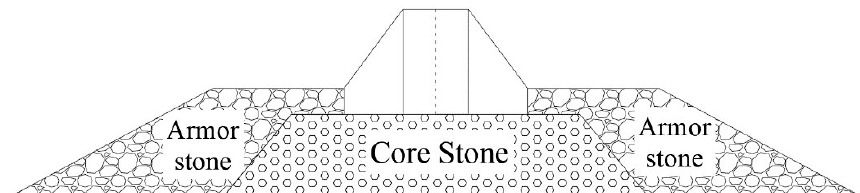
Figure 5. The cross section of a spur dike with tooth-shaped structures (cm) [27].